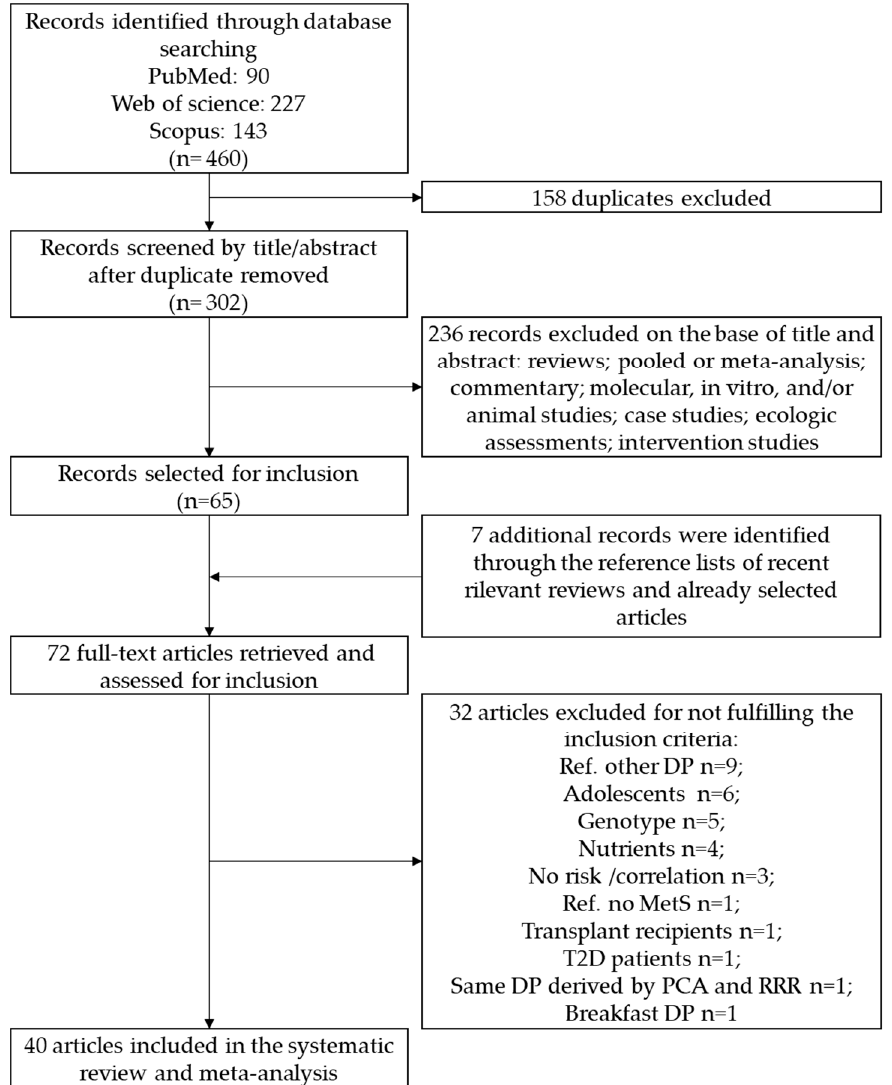
Figure 1. Flow diagram of the systematic literature search on dietary patterns and MetS risk. Metabolic Syndrome (MetS).